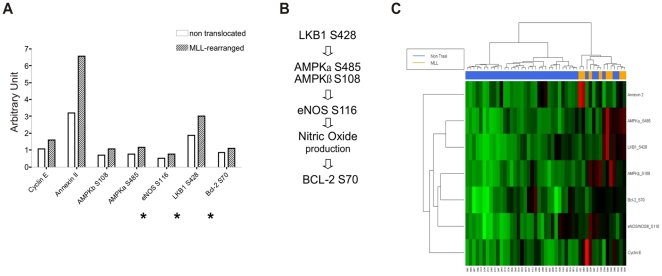
Hyperactivation of the AMPK pathway in MLL-rearranged patients.(A) Histogram of proteins, that are part of the AMPK pathway, found to be differentially activated (Wilcoxon test with Benjamini-Hochberg multiplicity correction, p<0.05) between the MLL- and non-translocated cohorts. * indicates proteins that are part of the AMPK pathway, but that did reach statistical significance using Global Test analysis (p = 0.003). (B) Scheme of the AMPK pathway. (C) Heatmap with hierarchical clustering. The heatmap was generated with R Project using the proteins differentially expressed/phosphorylated in the “MLL-rearranged patients” group vs “non-translocated patients” group comparison. MLL-rearranged patients are highlighted in orange.